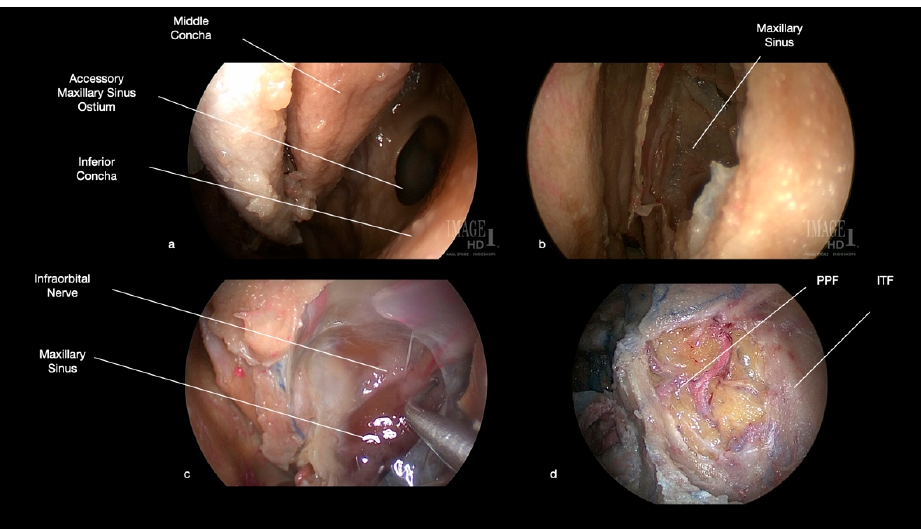
Figure 2. Anatomical endoscopic endonasal dissection (0° degree scope). ( a ) the natural and acces- sory ostia of the maxillary sinus are identified after resection of the inferior nasal concha and medi- alization of the middle one. ( b ) The semilunar hiatus is progressively enlarged to perform a medial maxillectomy. The frontal process of the maxilla is resected as much as necessary to achieve a suffi- cient exposure of the lateral part of the posterior wall of the maxillary sinus. ( c ) The most relevant anatomical structure in the superior wall of the maxillary sinus is represented by the infra-orbital nerve. ( d ) After resection of the posterior wall of maxillary sinus and opening of the periosteum, access to ITF and PPF is realized. (PPF: pterygopalatine fossa, ITF: infratemporal